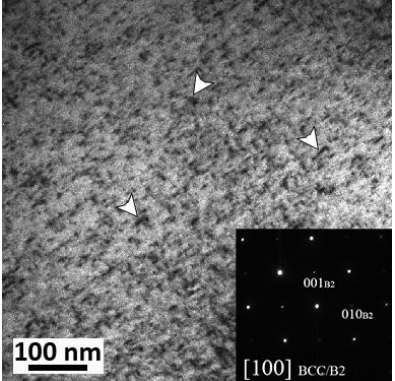
Figure 4. Typical Transmission Electron Microscopy (TEM) image and Selected Area Electron Di ff raction (SAED) pattern, taken from the AlCoFeNi (w / o Cr) alloy at [100] orientation. Matrix was found to be B2 and particles (marked by arrows) have a BCC